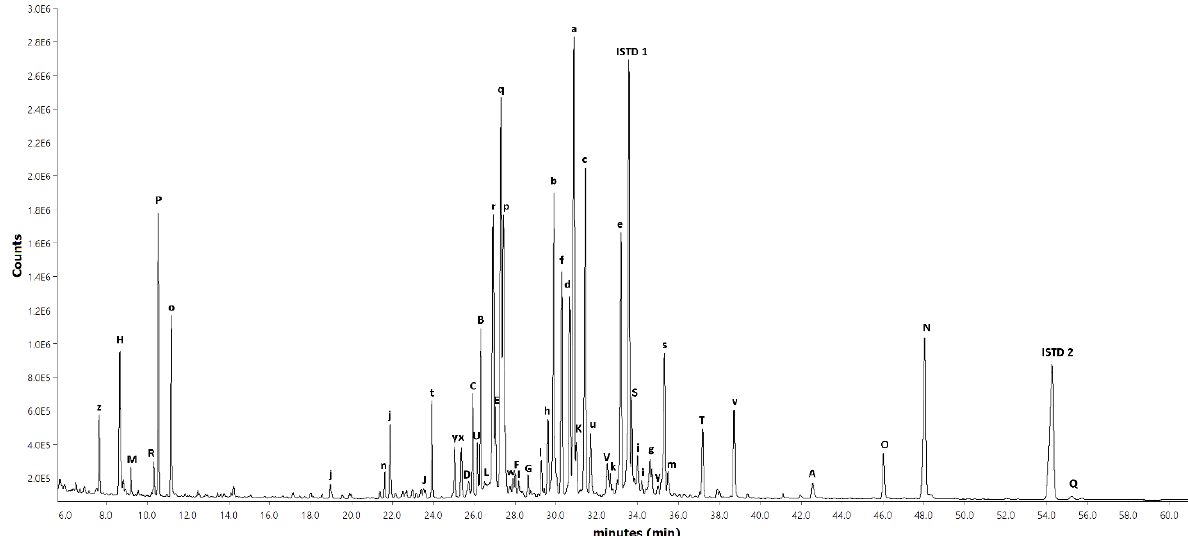
Figure A2. Reference gas chromatography with flame ionisation detection or mass spectrometry (GC-FID/MS) chromato- gram for hexane extract of spruce bark (esterified compounds). For alphabetical peak symbols, see Table 3.